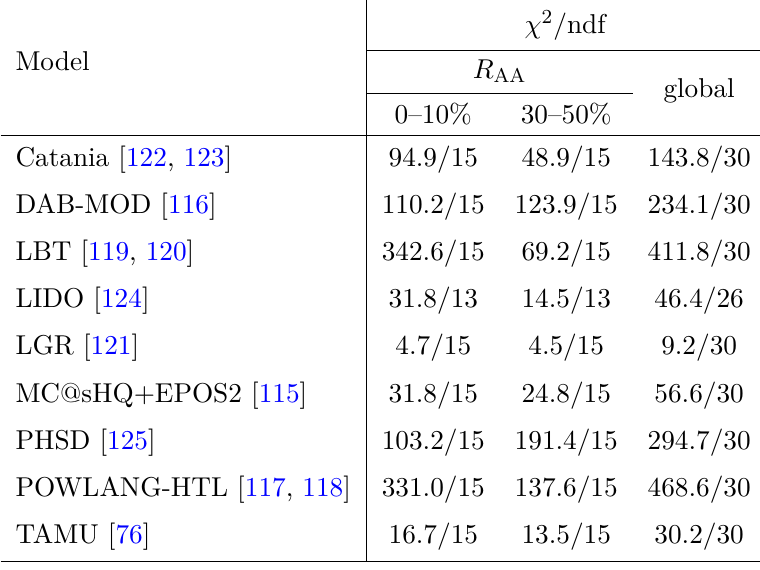
Table 5 . Summary of the χ 2 / ndf values obtained in 0 < p T < 8 GeV /c for the different model predictions compared with the measured D-meson R AA